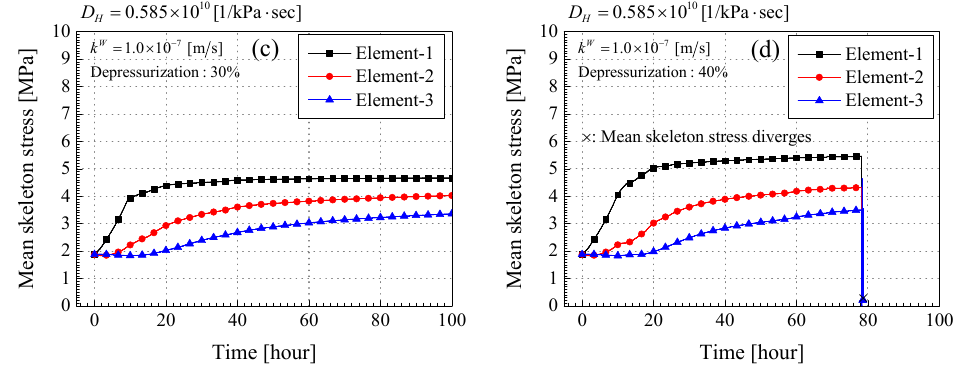
 (MPa). ( a ) Case-4-30; m